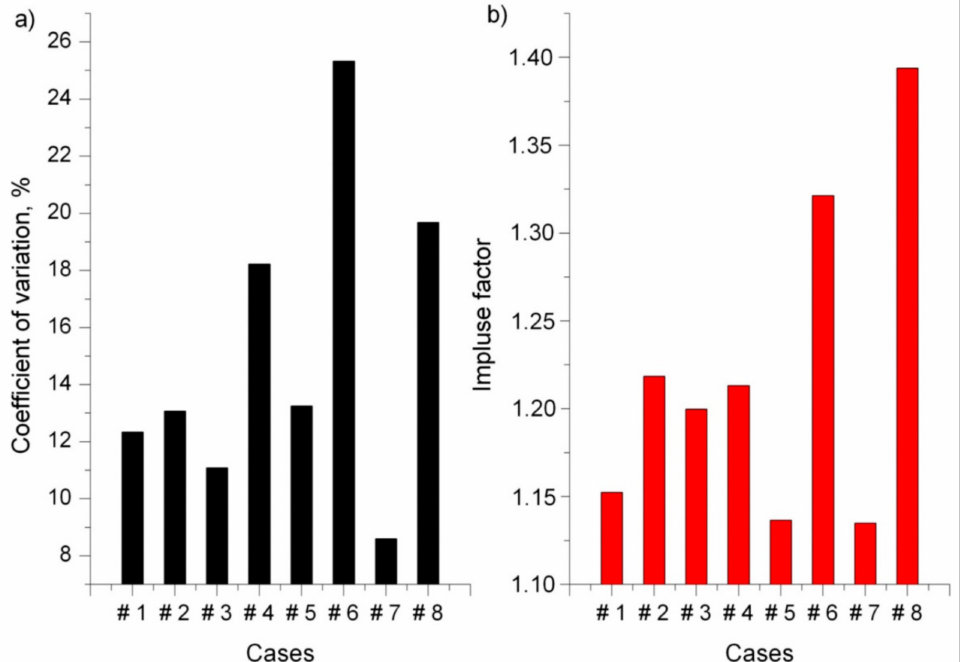
Figure 17. Diagnostic factors of wheeled bogies for cases #1 to #8 of non-uniform strain distribution: